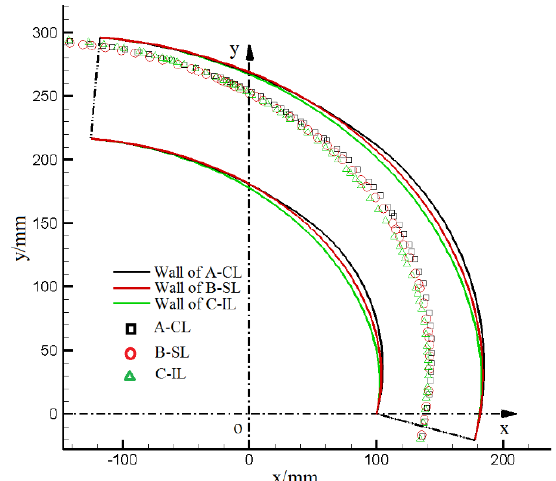
Figure 9. Effects of Cr on particle trajectory. Table 6. Effects of Cr on particle motion time through the whole duct.